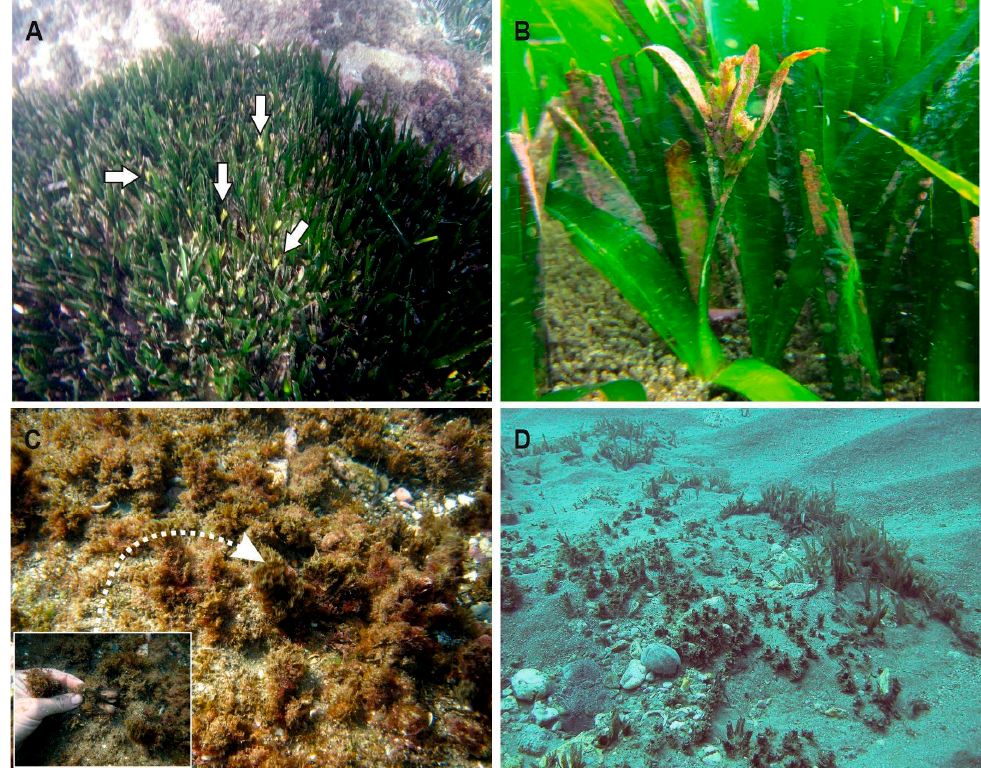
Figure 2. ( A ) Posidonia oceanica patch with several inflorescences (arrows) and ( B ) detail of one in- florescence from Calahonda SAC meadows, November 2015. ( C ) Dead matte covered by macroalgae (mainly Halopteris scoparia ) from Calahonda SAC meadows. ( D ) Dead matte from Maro MPA mead- ows after burial due to sediment transport linked to a torrential rainfall in September